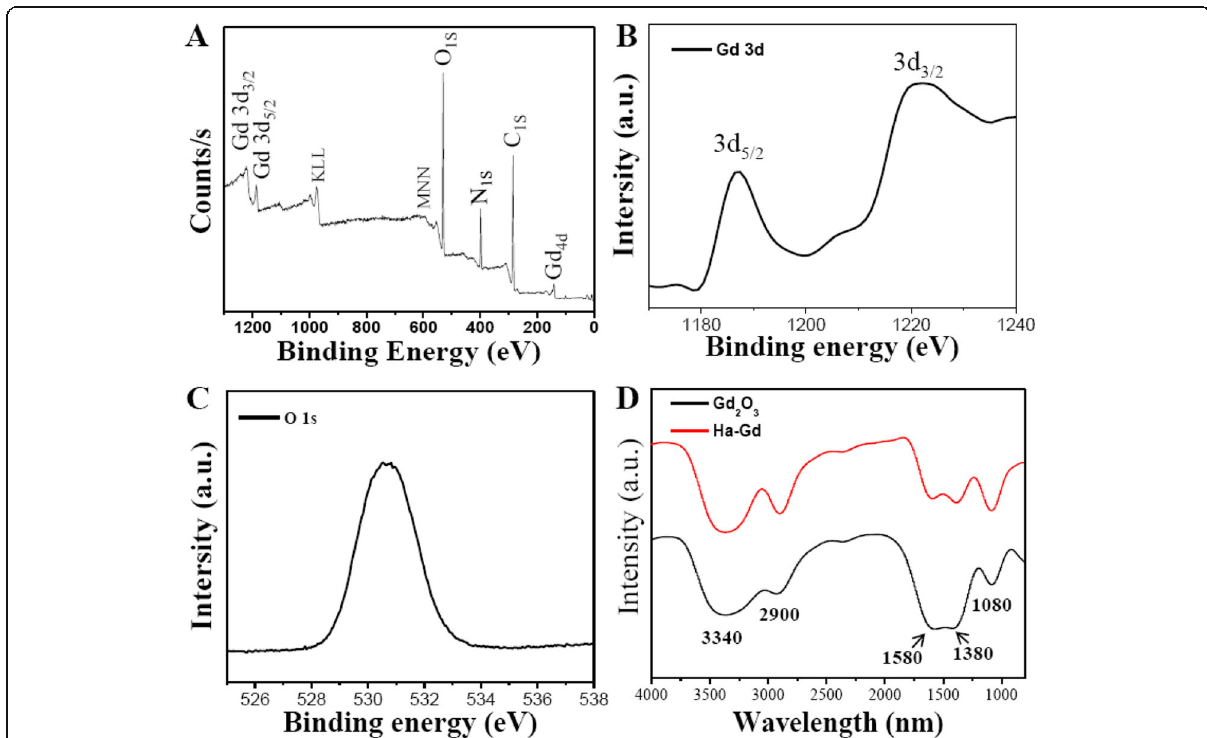
Fig. 2 The chemical structure and composition of the HA-Gd 2 O 3 NPs. a The full-scan XPS spectrum of HA-Gd 2 O 3 NPs. b Gd 3d spectrum. c O 1S spectrum. d The FTIR spectrum of HA-Gd 2 O 3